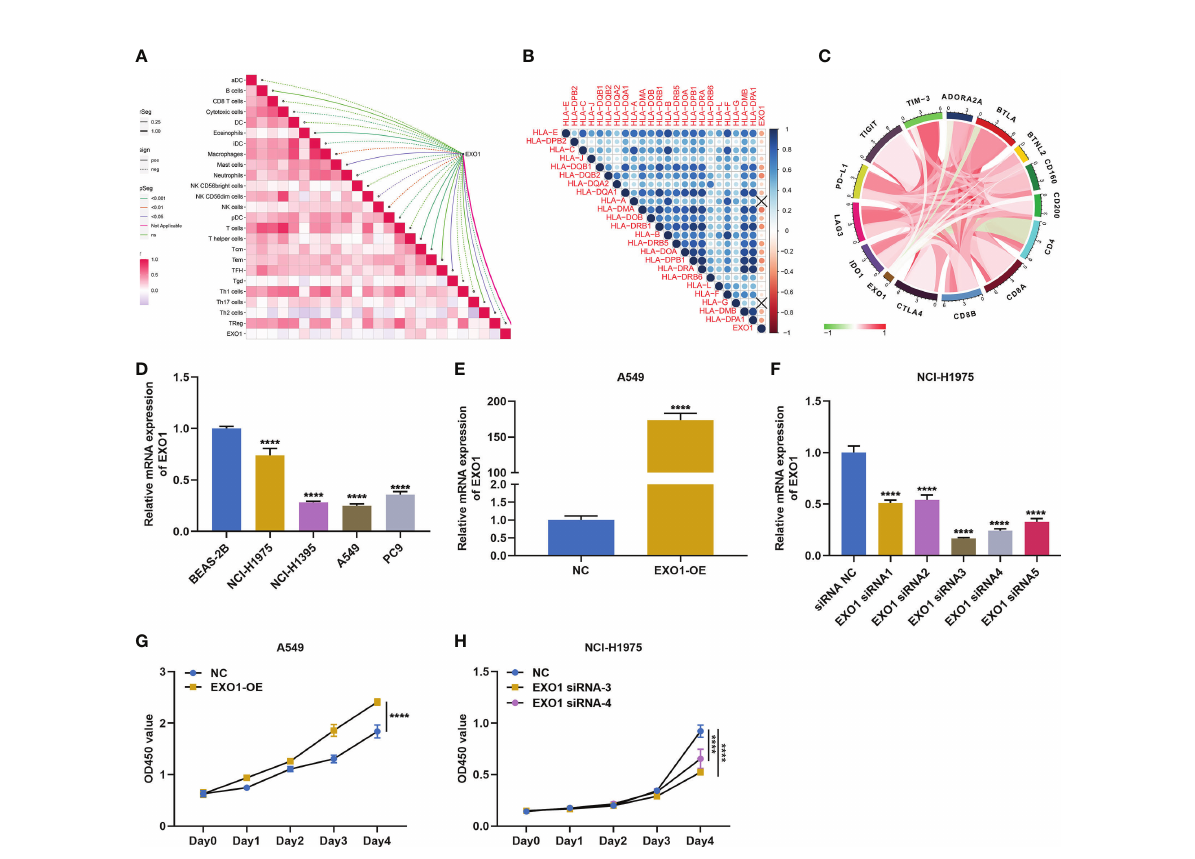
FIGURE 7 EXO1 correlates to antitumor immunity and is essential for growth of LUAD cells. (A – C) Associations of EXO1 mRNA level with (A) immune in fi ltrates, (B) MHC molecules, and (C) immune checkpoints in LUAD. (D) EXO1 mRNA level in human lung normal epithelial and LUAD cells. (E) EXO1 mRNA level in A549 cells overexpressing EXO1 (EXO1-OE). (F) EXO1 mRNA level in NCI-H1975 cells with EXO1 knockdown (EXO1- siRNA). (G, H) CCK-8 for quantifying optical density (OD) to evaluate proliferation of A549 cells with EXO1-OE and NCI-H1975 cells with EXO1- siRNA. ****p < 0.0001. LUAD, lung